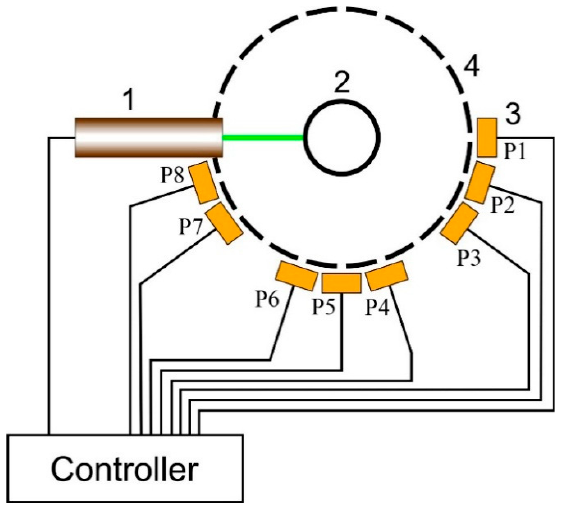
Figure 1. Optical scheme of the laser scatterometric sensor: (1) laser diode with a wavelength of 532 nm; (2) cylindrical tube of 15 mm diameter filled with flowing milk; (3) axial photodiode array P1-P8; (4) ring with rectangular diaphragms.